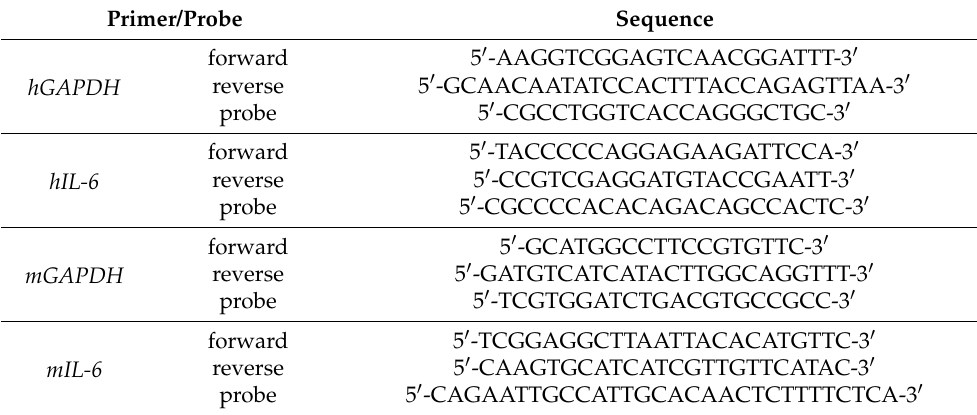
Table 3. Primers and probes used in